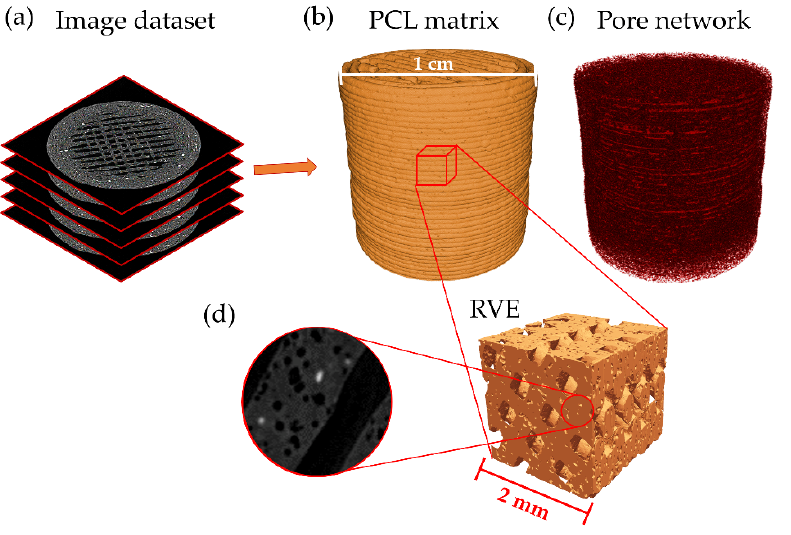
Figure 9. Schematic representation of microCT analysis showing ( a ) three-dimensional models; ( b ) PCL matrix; ( c ) pore network obtained from the images; and ( d ) one RVE extracted from the structure was shown with a magnified sector showing the porous filament.